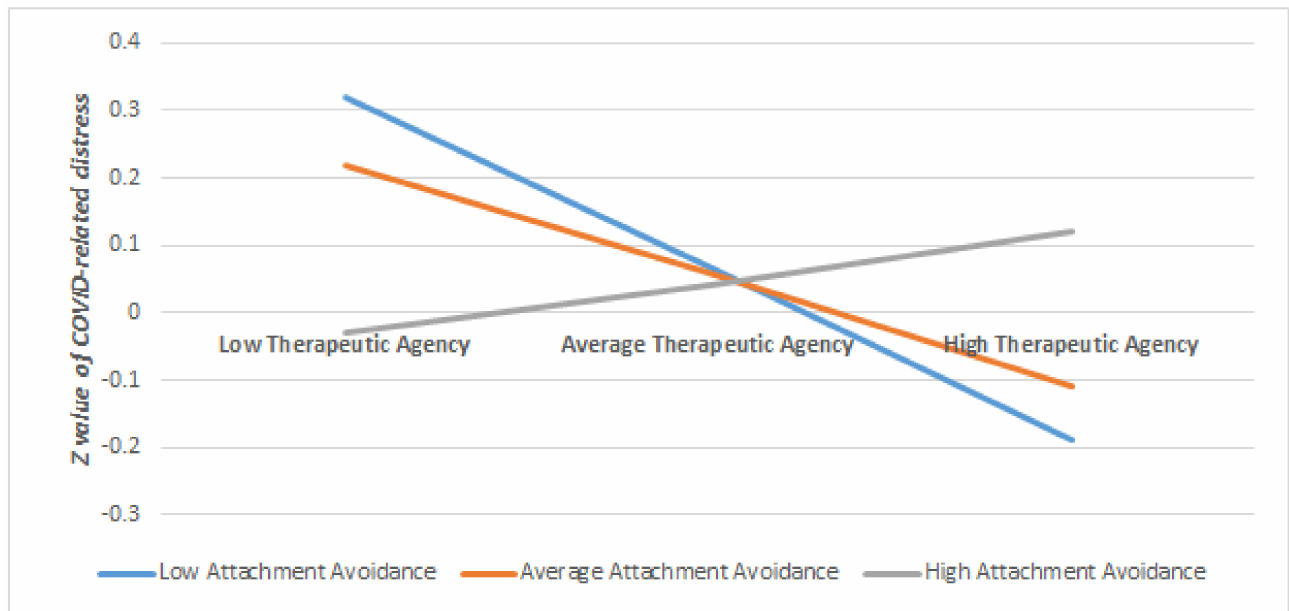
Figure 1. The Moderating Role of Attachment Avoidance on the Relationship between Therapeutic Agency and COVID- related Traumatic Distress at Follow-up, once Controlled for Baseline Distress and Time